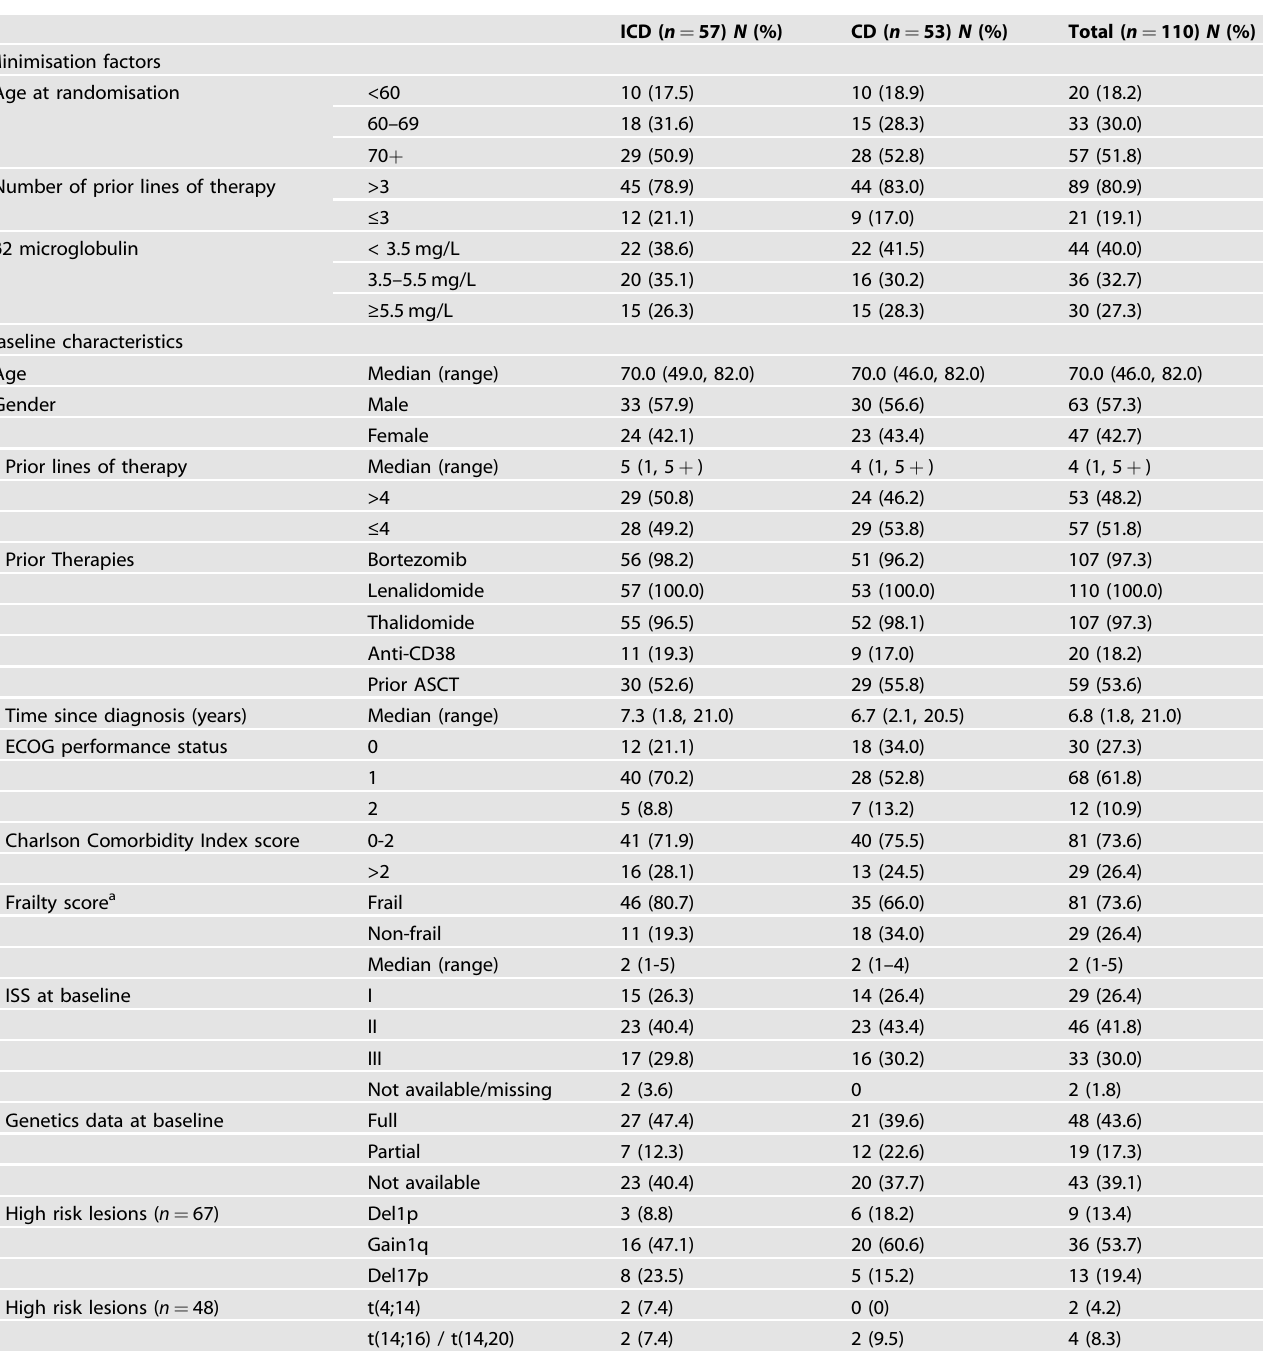
Table 1. Minimisation factors and baseline